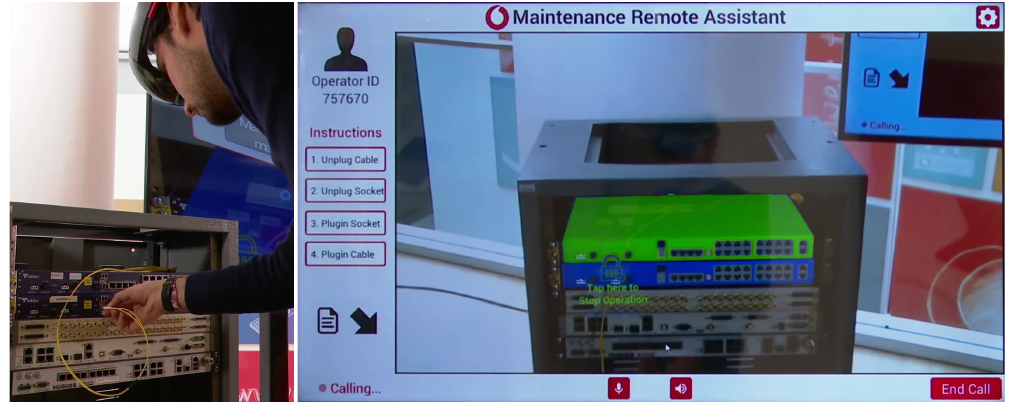
Figure 8. A snapshot of a remote call with real-time augmented reality interaction: ( left ) the on-field operator follows the instructions provided by the remote assistant; ( right ) the monitor of the remote assistant displays a replica of the AR scene as seen by the operator; the devices involved in the maintenance intervention are highlighted by superimposing and visualizing the respective holograms on the